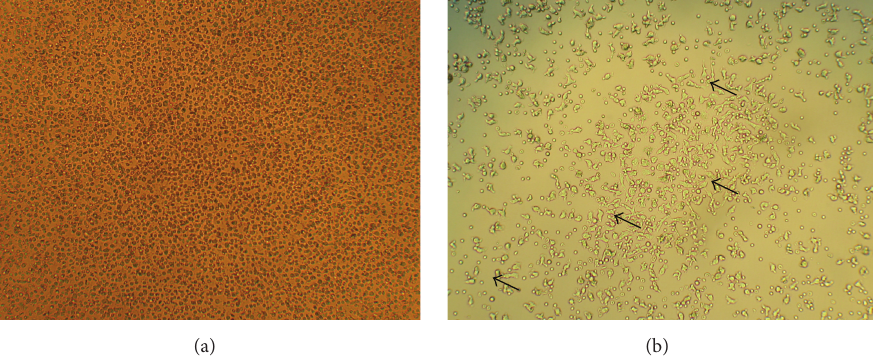
Figure 2: Observation of the cultured PMNCs. On day 1, the cells still display morphology resembling mononuclear cells (a). After 5-day culture, some of the cells exhibit spindle-like morphology (arrow), indicating that the cells are becoming more eEPCs like (b). Original magnification 100x.